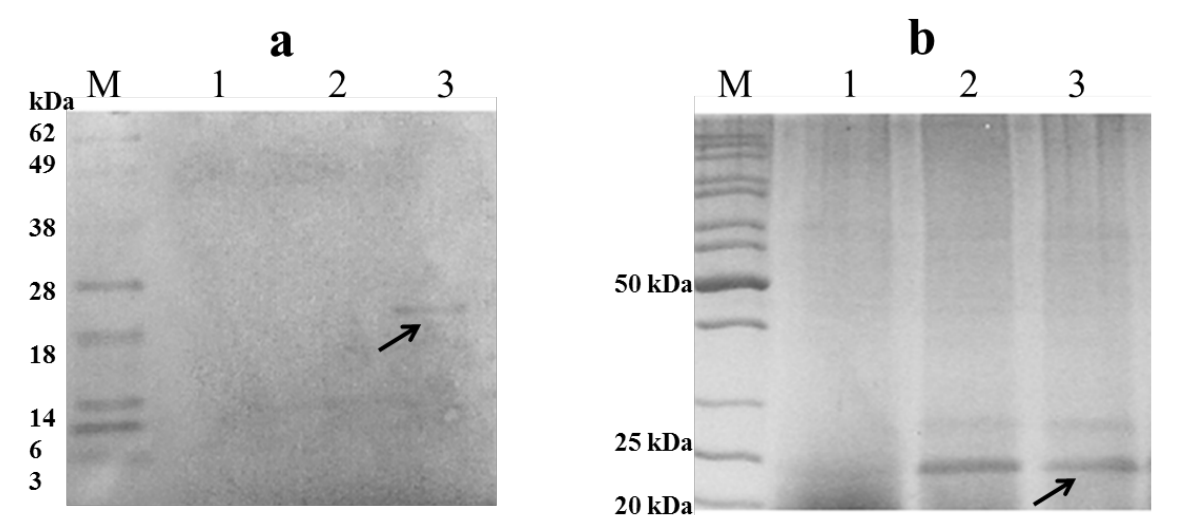
FIGURE 5 - a) Western-blot analysis of culture supernatants of GS115 strain of P. pastoris expressing INF-β-1a using the Anti-6X His tag® antibody (HRP). Lane1: Negative control; Lane 2: The non-concentrated sample; Lane 3: The concentrated sample; M: Prestained protein marker (kDa). b) SDS-PAGE analysis of protein purification using Ni-NTA resin column. Lane 1: Flow-through fraction after loading of concentrated protein into the column; Lane 2: Flow-through fraction after washing the column with a buffer containing 20 mM imidazole; Lane 3; Flow-through fraction after elution with a buffer containing 250 mM imidazole; M: protein marker